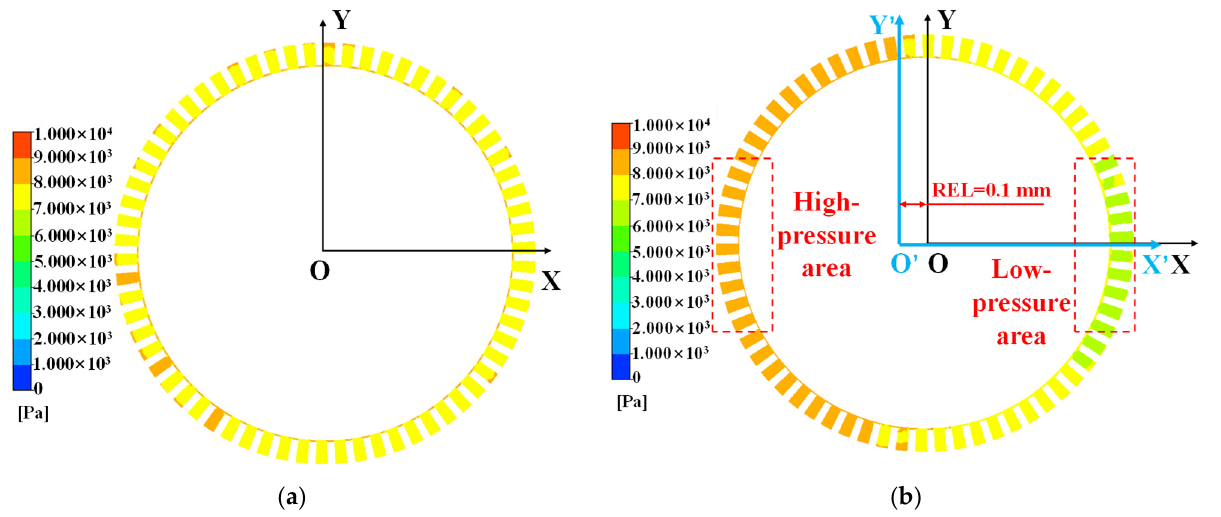
Figure 11. Radial pressure distribution diagram of honeycomb seal. ( a ) RE = 0 mm; ( b ) REL = 0.1 mm.